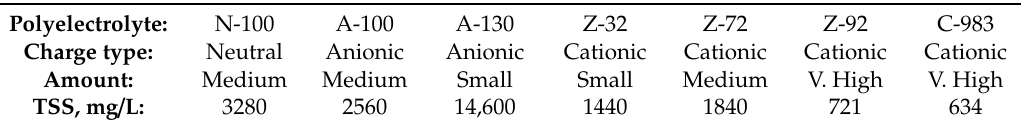
Table 2. E ff ectiveness of PEs in settling 22,000 mg / L of total suspended solids (TSS) in palm oil e ffl uent using 50 mg / L of PE (from